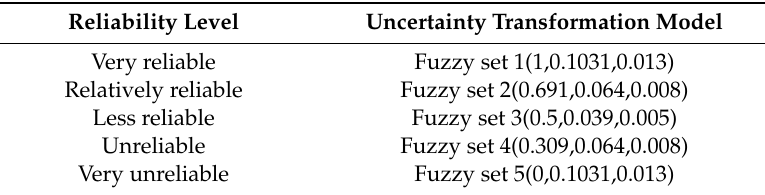
Table 2. Reliability rule of the air tra ffi c network.